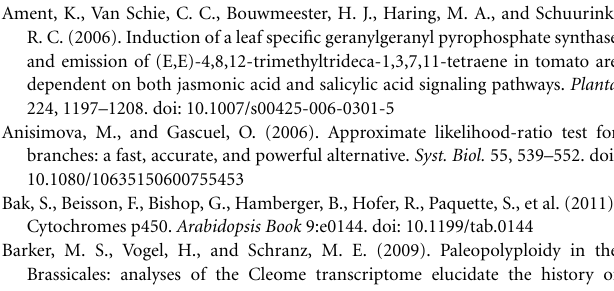
Supplementary Figure 1 | Maximum likelihood consensus tree of the GGPPS homologs from plants. Posterior probabilities are shown. Branch lengths correspond to evolutionary distances. Branch colors represent the major plant lineages: spring green, green algae; orange, mosses; dark green, gymnosperms; and blue, angiosperms. Supplementary Figure 2 | Amino acid MSA of 119 GGPPS homologs from plants. The CxxxC motifs are shown in gray. The FARM and SARM motifs are shown in purple. Supplementary Figure 3 | Syntenic relationships of GGPPS paralogs from A. thaliana using C. papaya as outgroup. (A) Blocks duplicated by WGD and harboring GGPPS11 and GGPPS12 are shown. Their orthologs found in syntenic region of C. papaya genome are indicated by red connecting lines. (B) GGPPS2 , GGPPS3 , GGPPS4 and GGPPS11 paralogs from A. thaliana found within α -WGD blocks on chromosome 2 and 4, respectively, are shown. Only GGPPS2 and GGPPS11 are retained as a pair (connected by red line), whereas the counterparts of GGPPS3 and GGPPS4 appear to have been lost from the corresponding syntenic region. Each genomic region spans 100kb. The GGPPS paralogs and their orthologs from C. papaya are shown as red arrows. Blue arrows indicate anchor genes and they are connected by blue lines if retain within a WGD block. Supplementary Table 1 | 119 GGPPS protein sequences used for the phylogenetic tree reconstruction. Supplementary Table 2 | Polyprenyl synthase domain